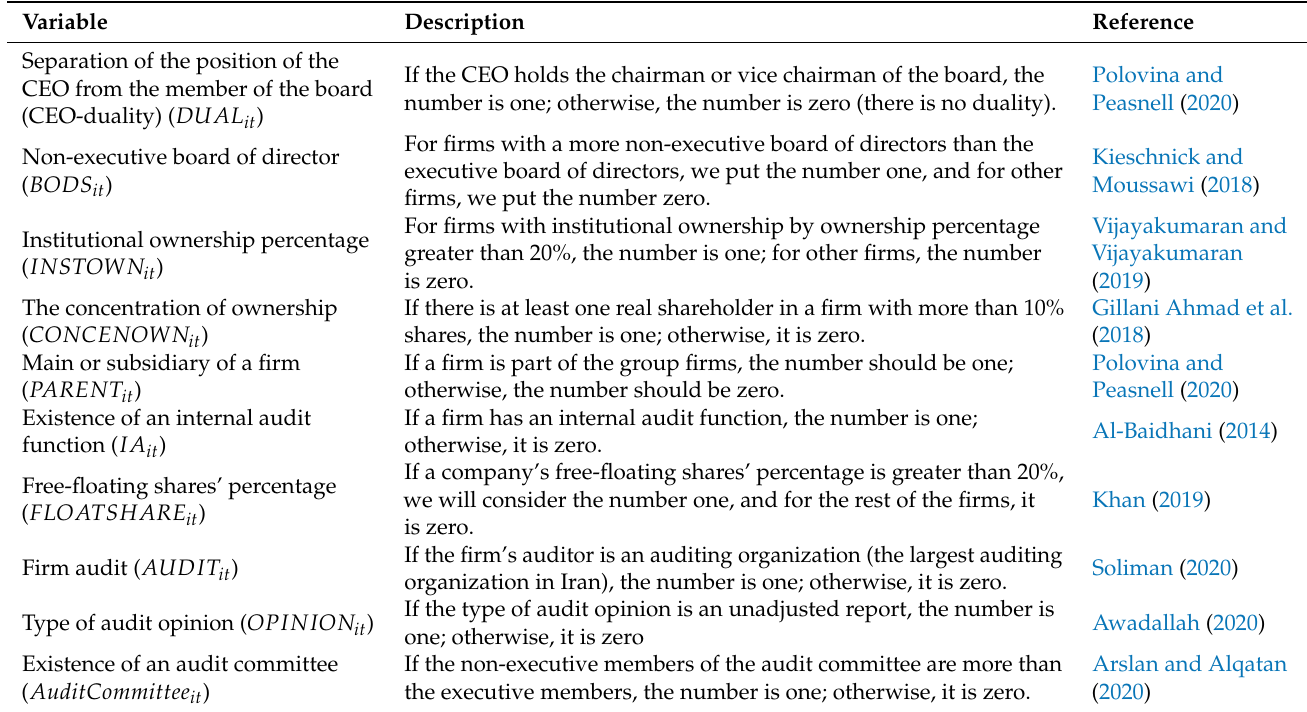
Table 1. Indicators for identifying the level of corporate governance